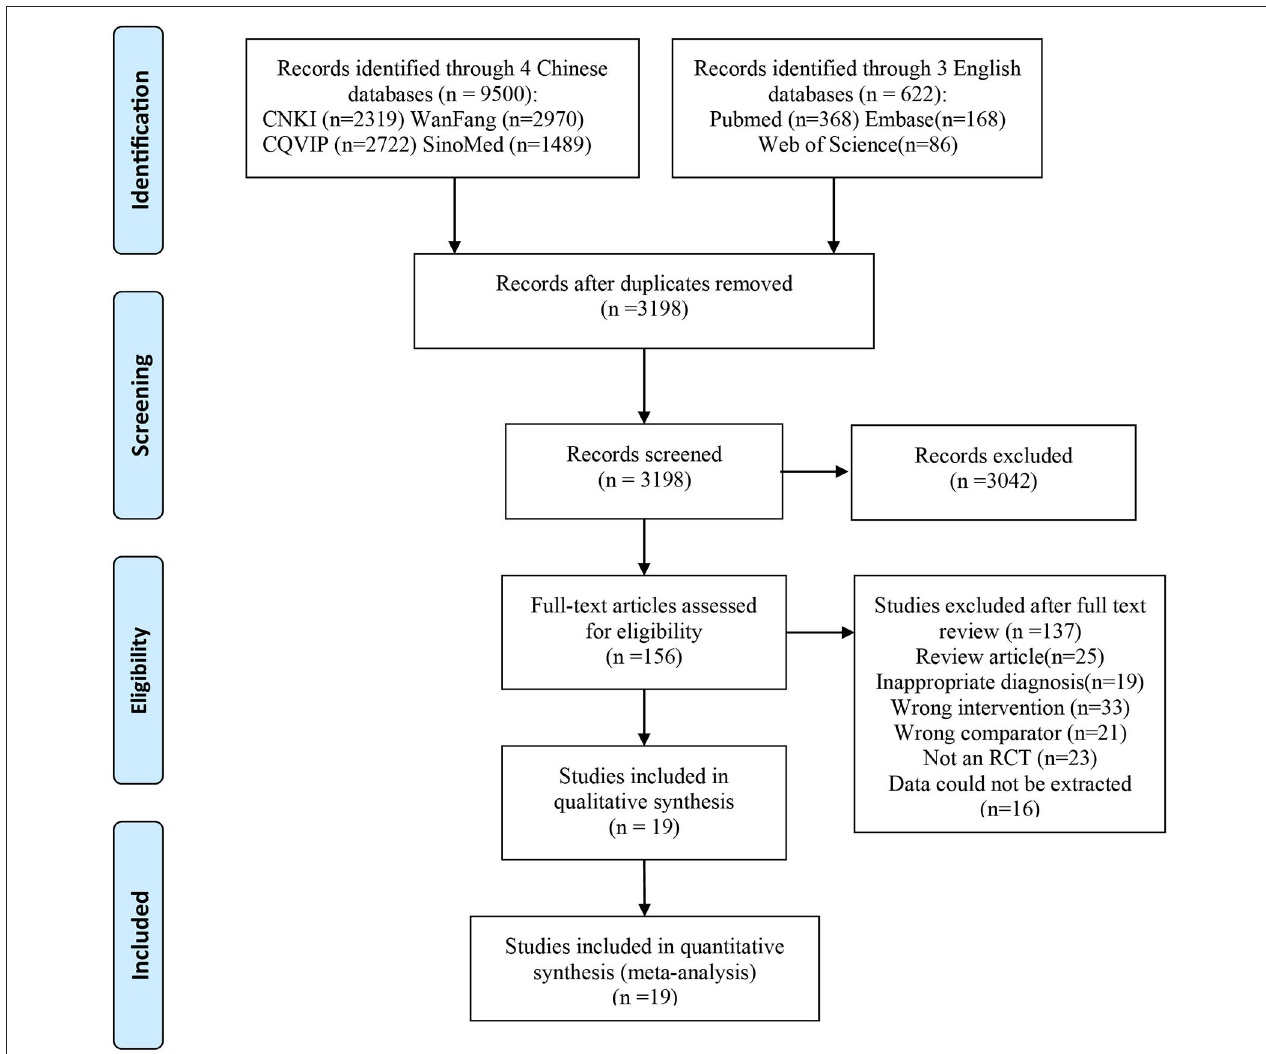
FIGURE 1 | Flow diagram of study